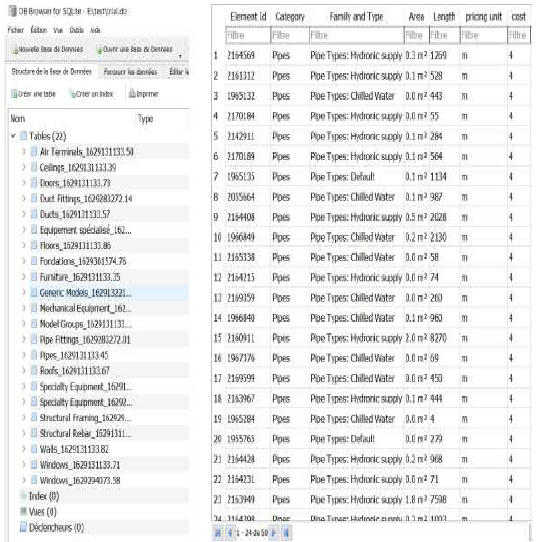
Figure 5. Outputs o f the clash coordination script.